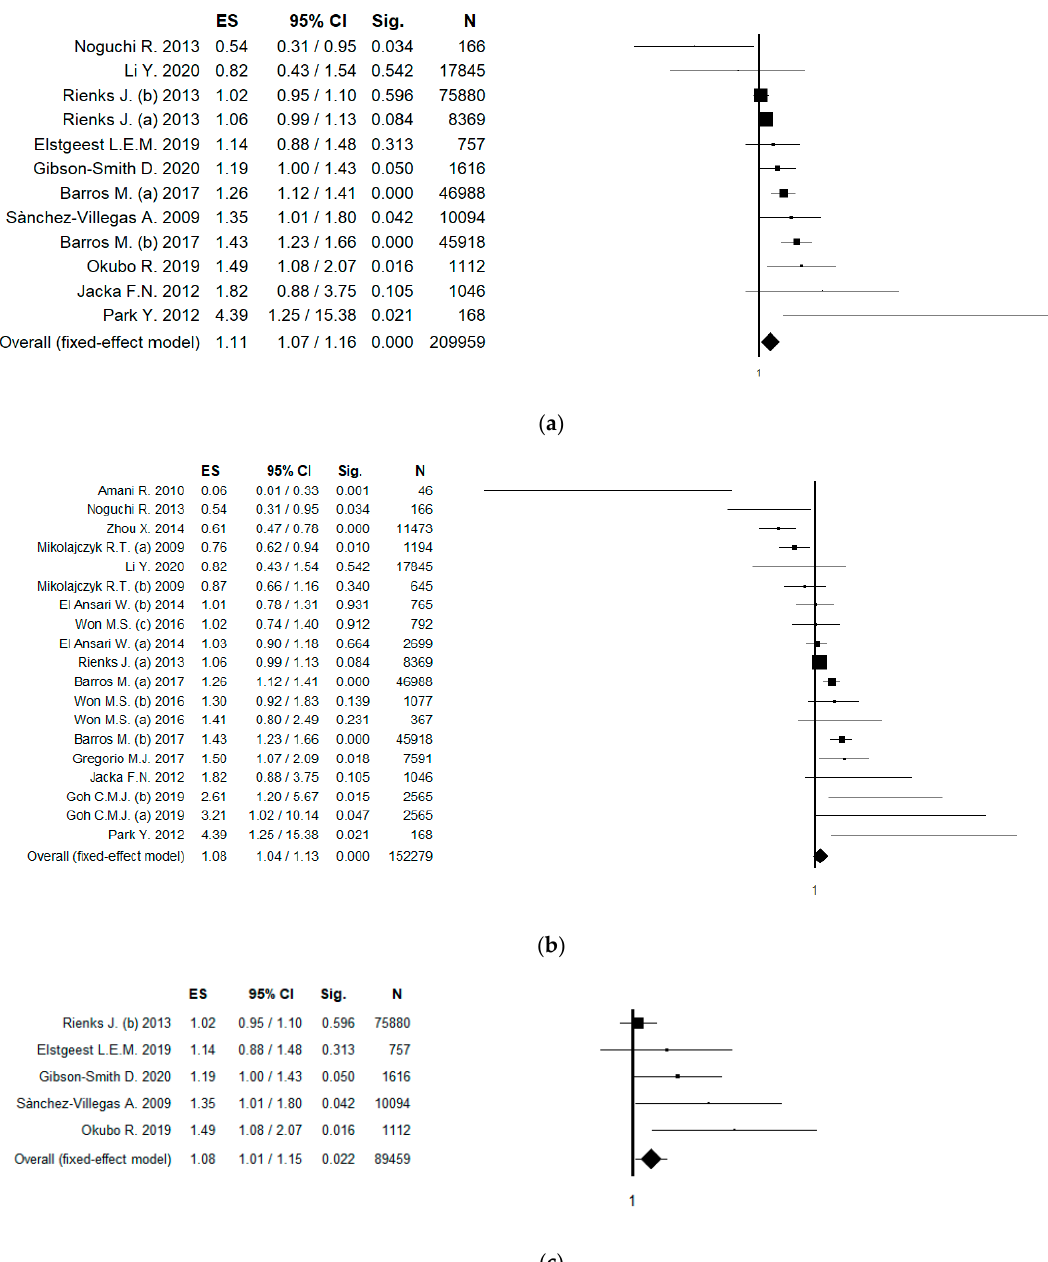
Figure 3. ( a ) Forest plot of the meta-analysis assessing the association between meat intake and depression, only including studies that used validated tools to assess meat intake; ( b ) forest plot and meta-analysis assessing the association between meat intake and prevalent depression (only including case-control and cross-sectional studies); ( c ) forest plot and meta-analysis assessing the association between meat intake and incident depression (only including longitudinal studies). ES, effect size; CI, confidence interval.